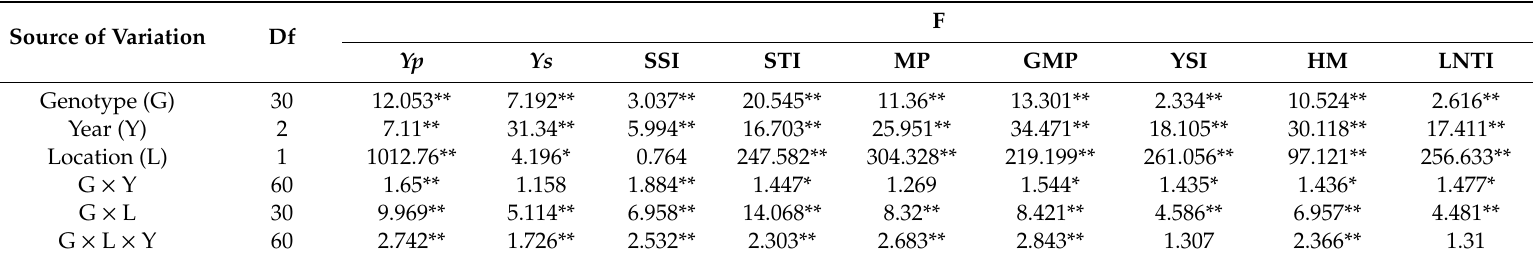
Table 2. Combined analysis of variance for the BLUP of grain yield under HN ( Yp ) and LN( Ys ) and seven screening index values for 31 inbred lines. Source of Variation